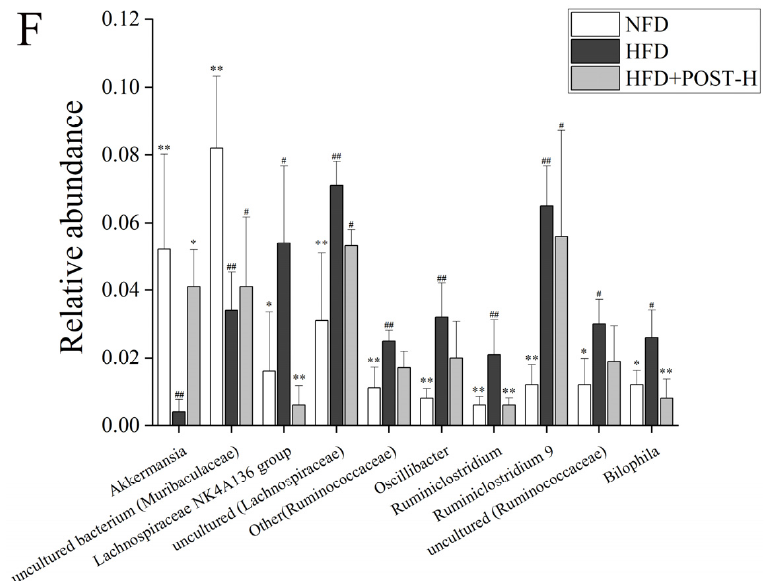
Figure 5. POST regulates gut microbiota. ( A ) PCoA analysis (PCoA1 = 52.5%, PCoA2 = 21.6%). ( B ) phylum-level microbial relative abundance ( C ) The value of F/B. ( D ) Cladograms for LEfSe analysis. ( E ) LDA scores. ( F ) The top 10 differential genera in relative abundance. Compared to HFD, * p < 0.05, and ** p < 0.01; Compared to NFD, # p < 0.05, and ## p < 0.01.